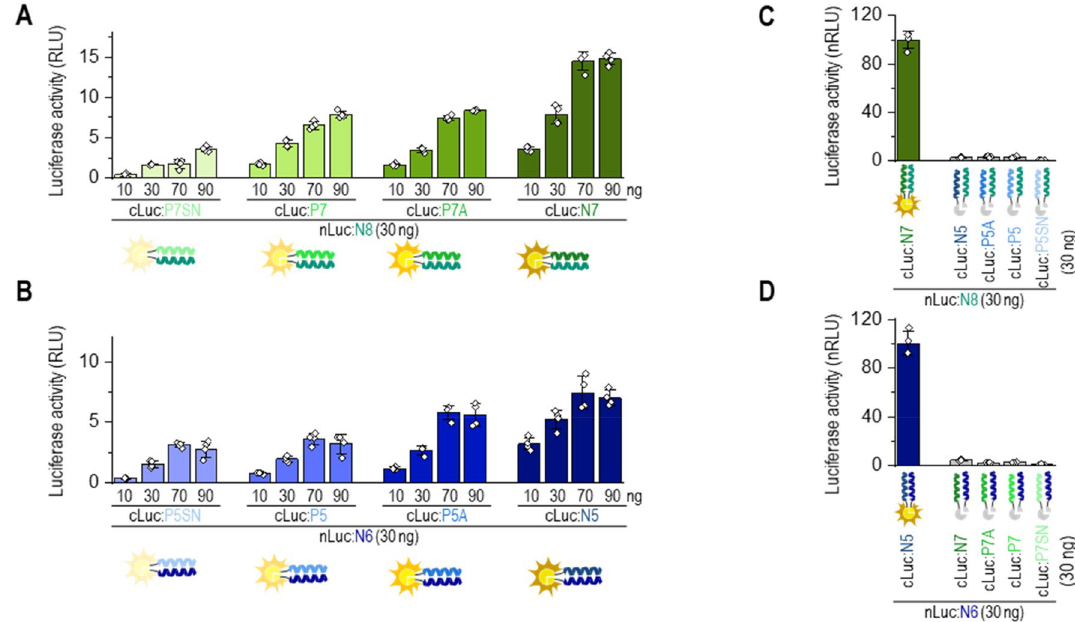
Figure 2. Reconstitution of split luciferase can be tuned by CC stability. Luciferase activity was determined 48 h after transfection of HEK293T cells with plasmids expressing nLuc:N8 or nluc:N6 (30 ng); and cLuc tethered to N7, P7A, P7, P7SN or to N5, P5A, P5, P5SN (10–90 ng). ( A , B ) Increasing amounts of plasmids expressing cLuc:CC resulted in increased luciferase activity. (C, D) Only orthogonal peptide variants with complementary electrostatic motifs formed functional luciferase. HEK293T cells were transfected with plasmids expressing nLuc:N8 or nluc:N6 (30 ng); and cLuc tethered to N7, P7A, P7, P7SN or to N5, P5A, P5, P5SN (10 ng).The values represent the means (± s.d.) from four independent cell cultures, individually transfected with the same mixture of plasmids, and are representative of two independent experiments. Amounts of used plasmids are indicated in Table